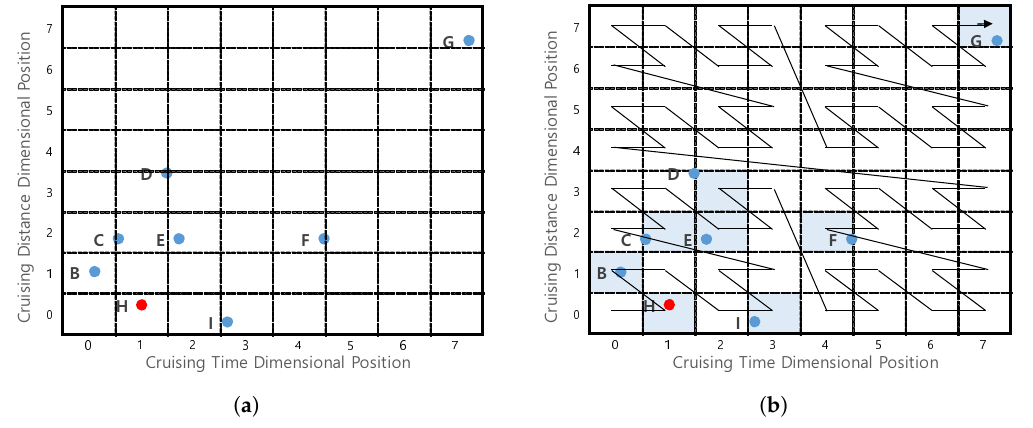
Figure 18. Computing Z-order values. ( a ) Dimensional positions; ( b ) Z-order